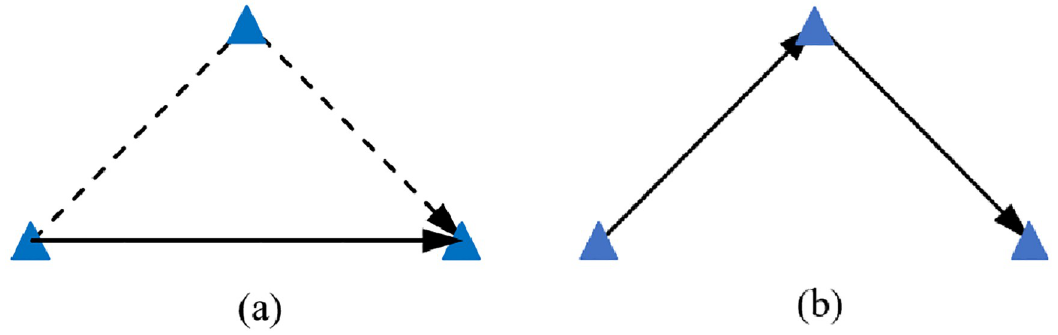
Fig 3. Terminal distribution route